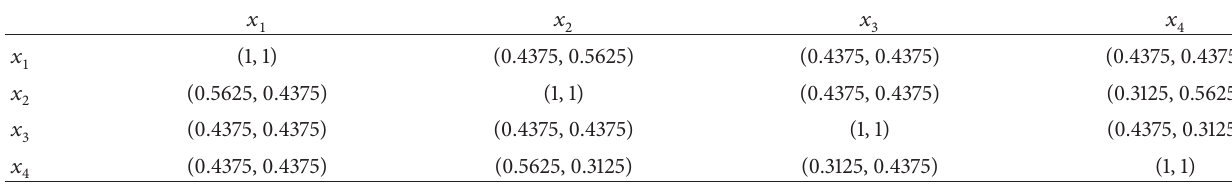
Table 3: Consistency levels of preference values provided by 𝑒 3 .